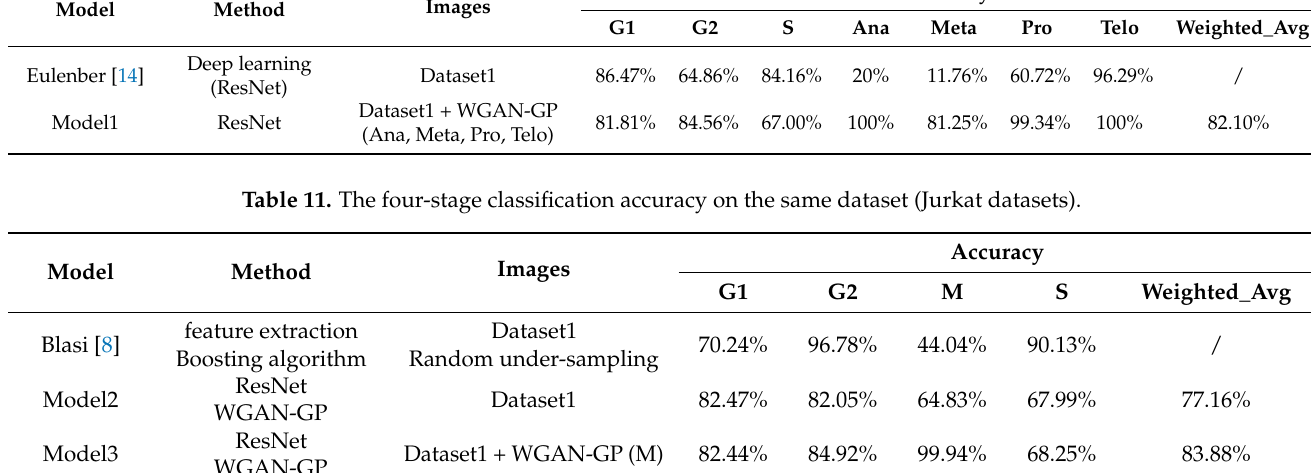
Figure 12. The ROC curves for classification. ( a ) Two-class classification of original images; ( b ) two-class classification of generated images.